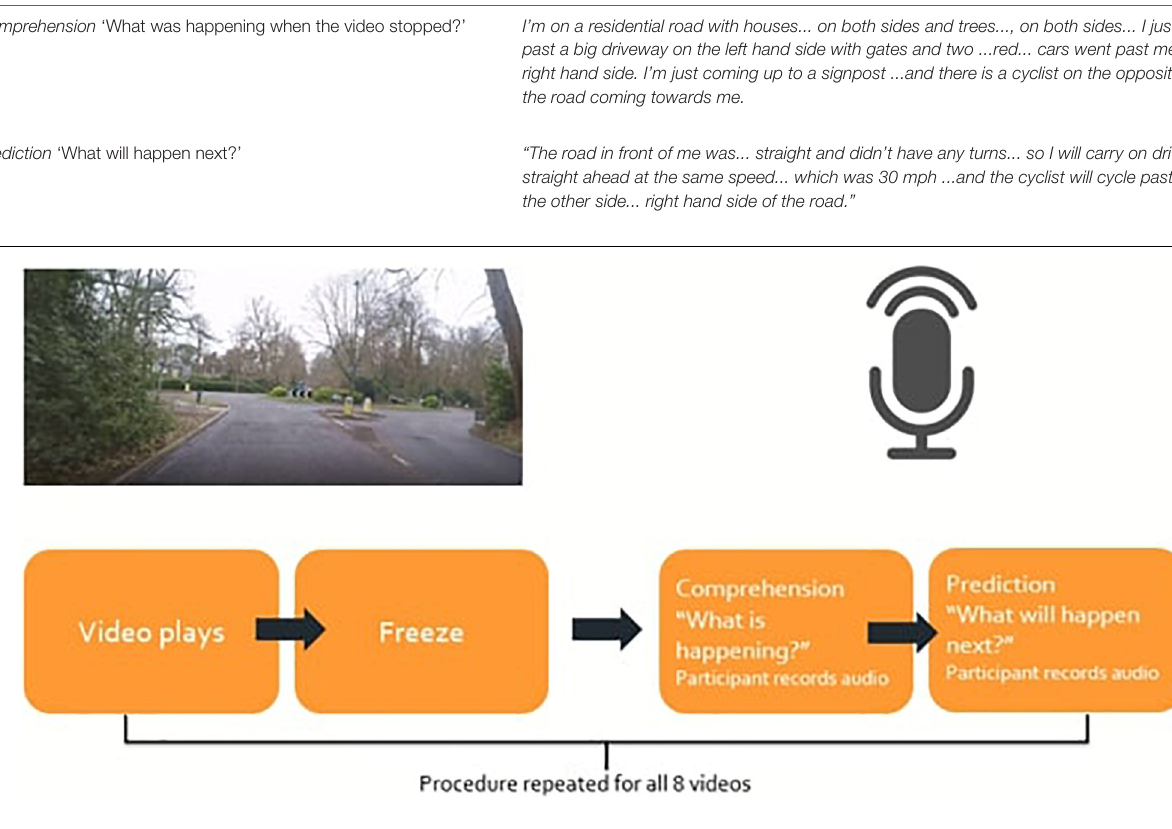
FIGURE 3 | Experimental